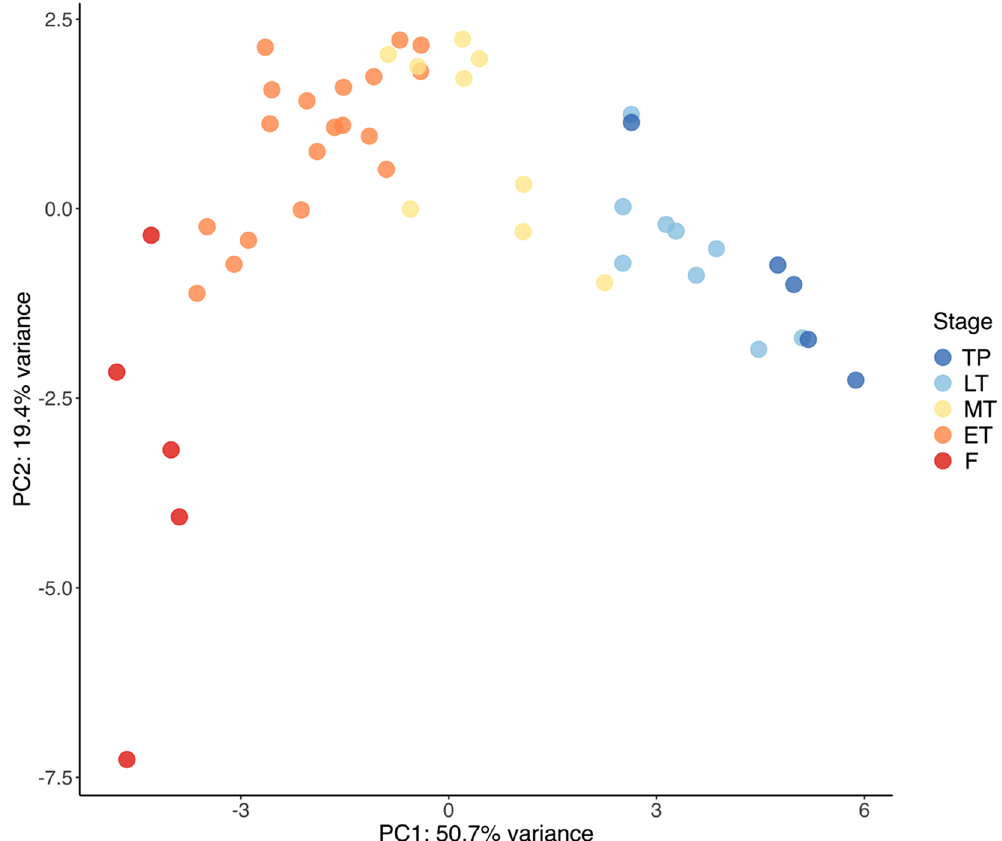
Figure 2. PCA (18 genes) of gonad samples. The transition from females to males is captured along PC1 (50.7% variance), whereas PC2 (19.4% variance) extremes represent sexually differentiated gonads (bottom) and undifferentiated transitionary gonads (top). Sample sizes: F n = 5, ET n = 19, MT n = 9, LT n = 9, TP n = 5. F control female, ET early transitioning fish, LT late transitioning fish, MT mid-transitioning fish, TP terminal phase